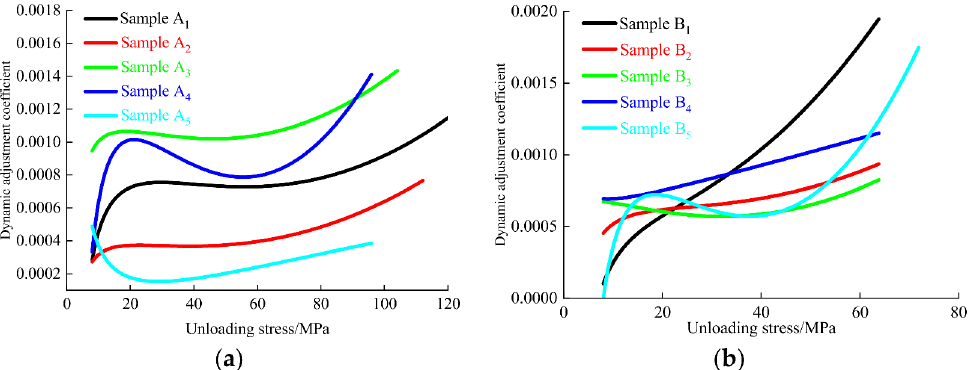
Figure 13. The trend of dynamic adjustment coefficient during cyclic loading and unloading of sandstone. ( a ) Dry rock samples. ( b ) Saturated rock